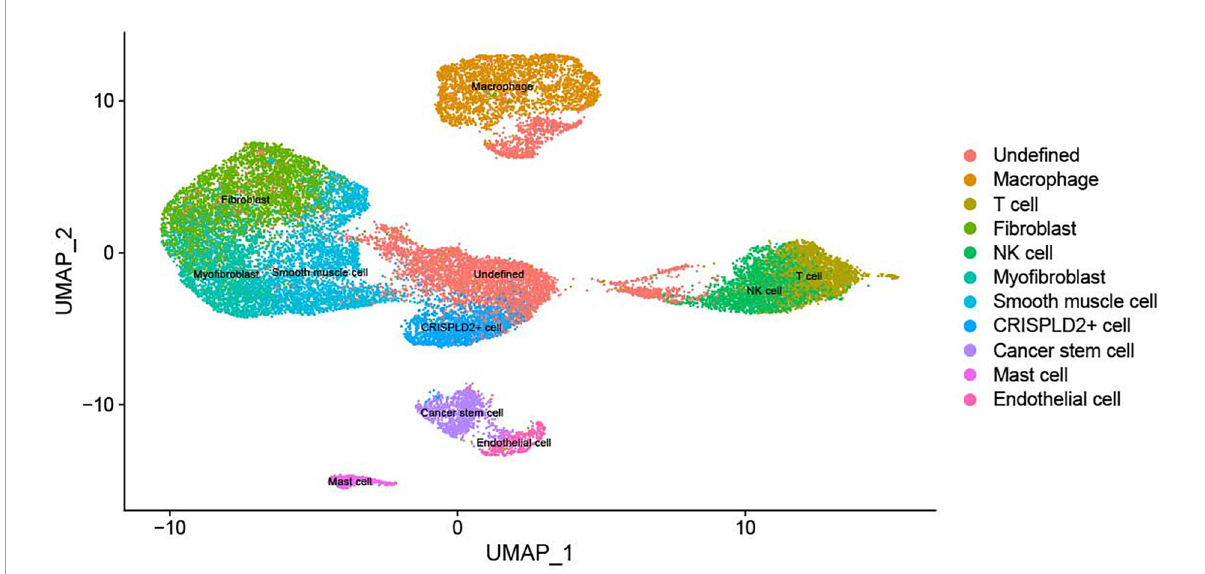
FIGURE1 The UMAP plot of 11 cell subtypes in all samples. Different colors indicate different cell